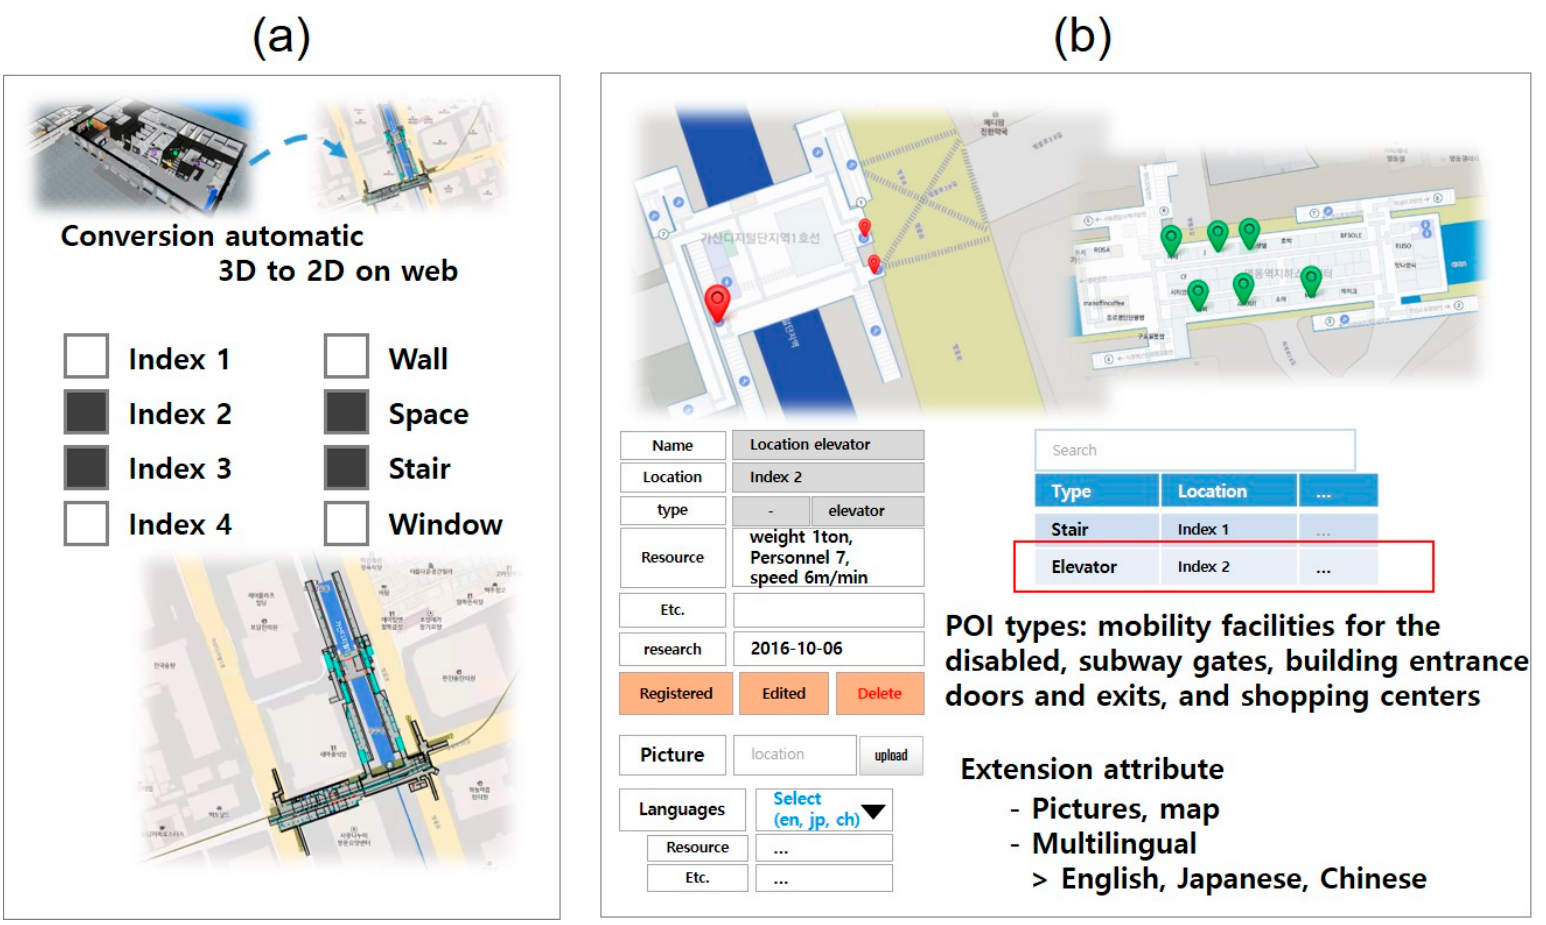
Figure 2. Two-dimensional (2D) data model for an indoor content management system: ( a ) geospatial object visualization and management, and ( b ) management mode of indoor points of interest (POIs) and open application programming interface (API).